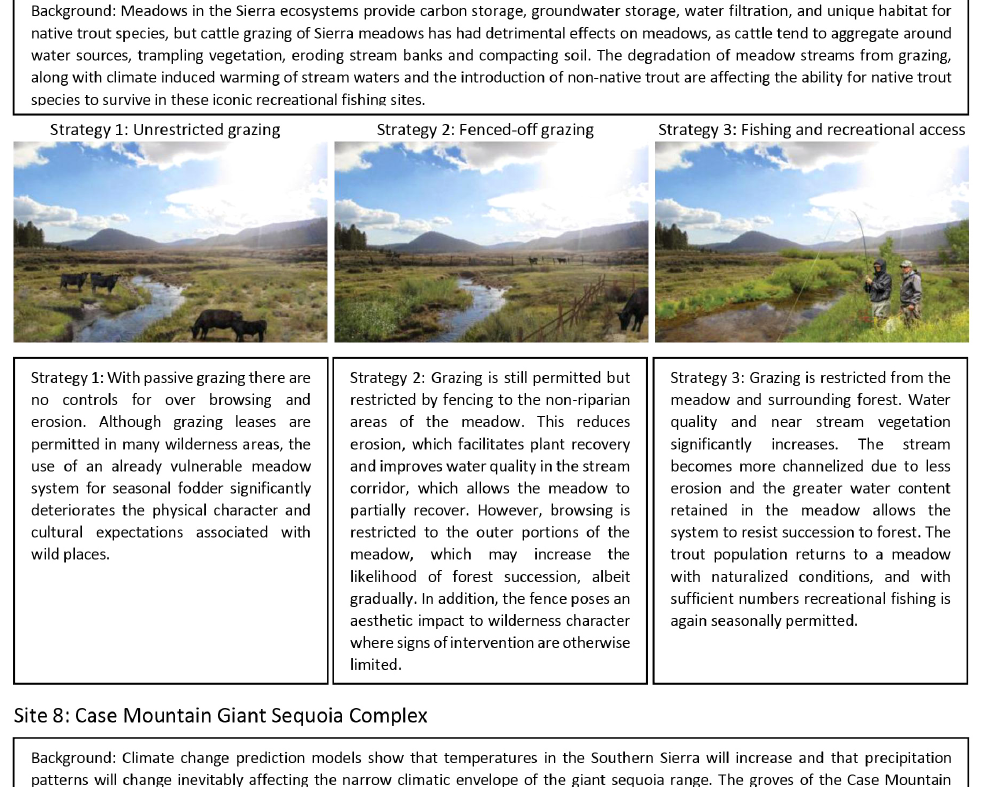
Fig. 2 . Site examples from the text-based version of the survey, including site 4 – Templeton Meadows in the Gold Trout Wilderness, and site 8 – Case Mountain Giant Sequoia